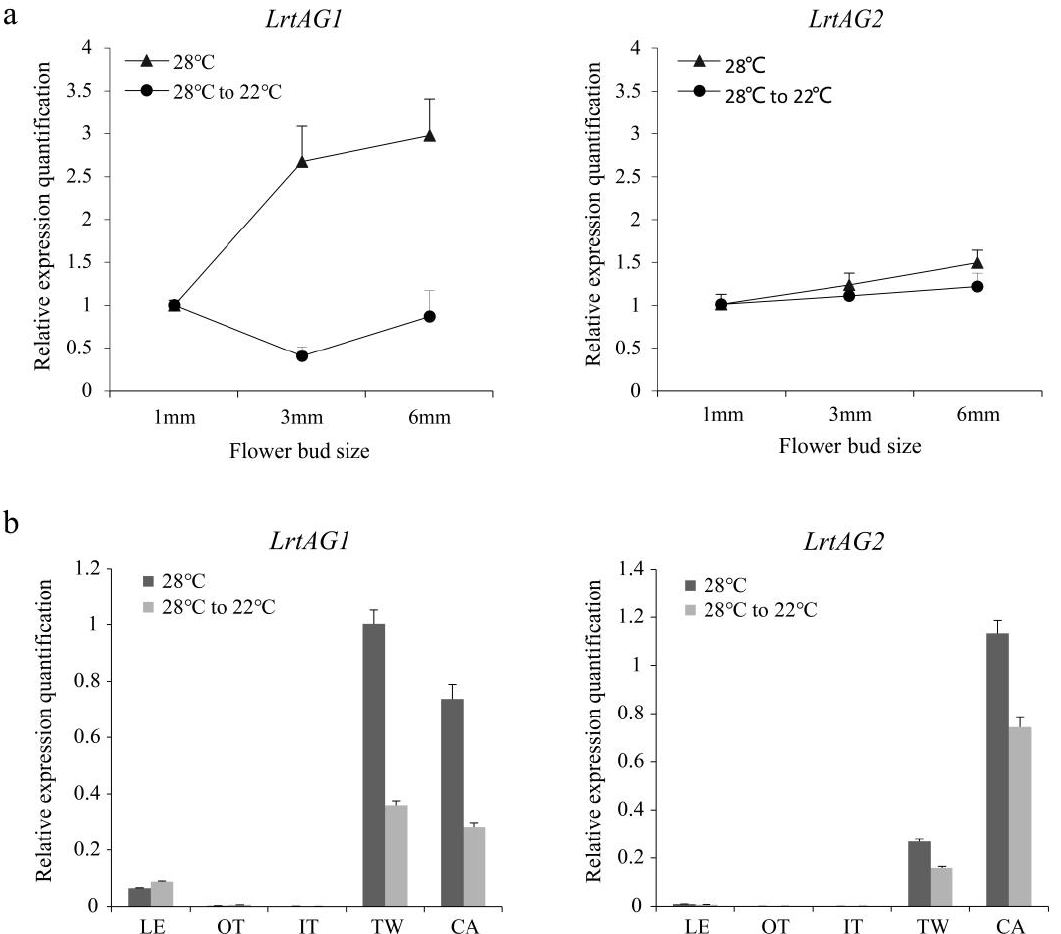
Figure 7. Expression profiles of LrtAG1 and LrtAG2 under different temperature treatments. ( a ) qRT- PCR analysis in first emerged flower buds (FFs) at different sizes (1 mm, 3 mm, and 6 mm) under two temperature treatments. ( b ) qRT-PCR analysis of the floral organs in four whorls of FFs at 3–6 mm and contemporaneous leaves under two temperature treatments. 28 ◦ C, flower buds developed at 28 ◦ C from undifferentiated to 6 mm. 28 ◦ C to 22 ◦ C, flower buds developed at 28 ◦ C from undifferentiated to 1 mm but at 22 ◦ C from 1–6 mm. LE, OT, IT, TW, and CA represent leaf, outer tepal, inner tepal, the third whorl floral organ, and carpel,